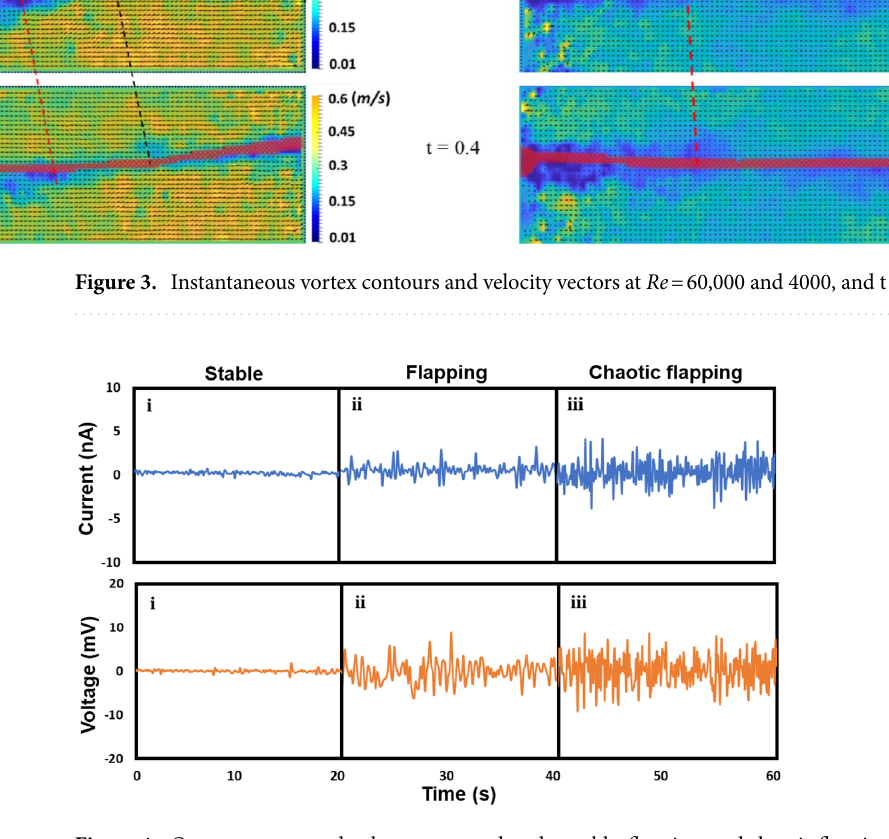
Figure 4. Output current and voltage measured under stable, flapping, and chaotic flapping